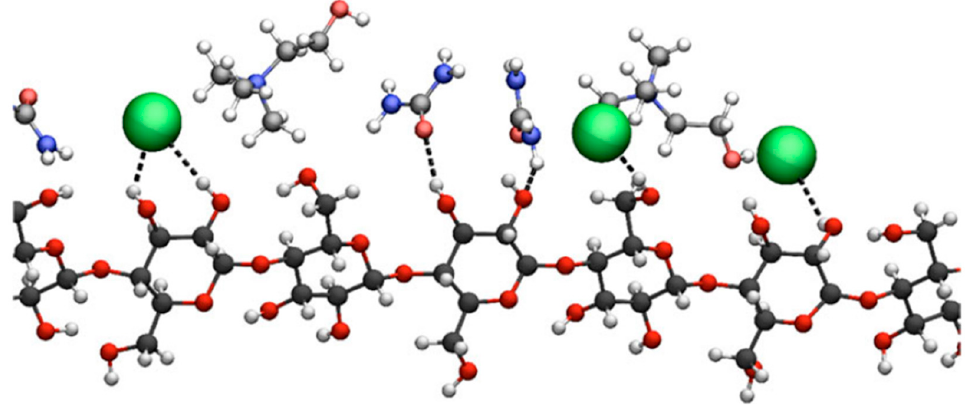
Figure 5. Snapshot illustrating the typical interactions of cellulose with Cl − ions and urea molecules. Gray dotted lines show H-bonds. Red balls represent oxygen atoms, blue balls—nitrogen atoms, white balls—hydrogen atoms, grey balls—carbon atoms and green balls—Cl − ions. Reprinted by permission from: Springer Nature, Cellulose, ref. [125], Copyright 2020.